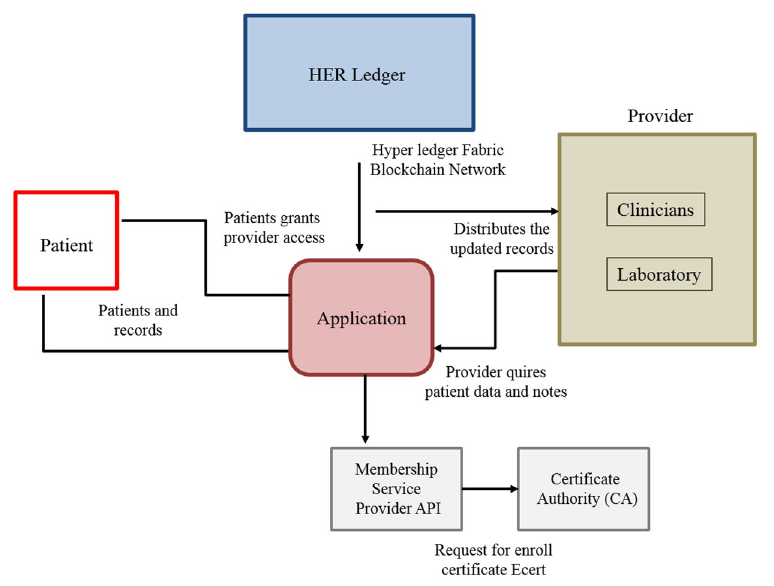
Fig 8. Records of